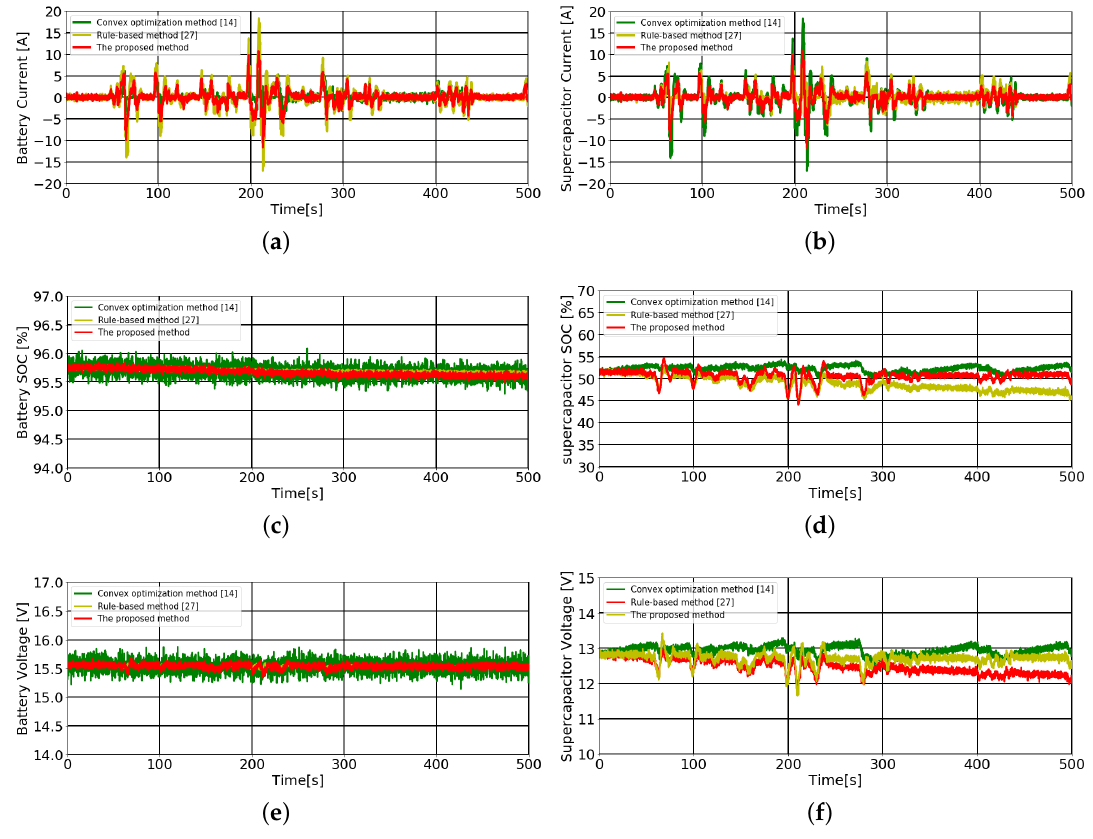
Figure 11. The proposed method, the real-time frequency-based method [27], and the off-line optimization method [14] on the NYCC dynamometer driving schedule. ( a ) Current of battery profiles; ( b ) Current of supercapacitors profiles; ( c ) SOC of battery profiles; ( d ) SOC of supercapacitors profiles; ( e ) Voltage of battery profiles; ( f ) Voltage of battery